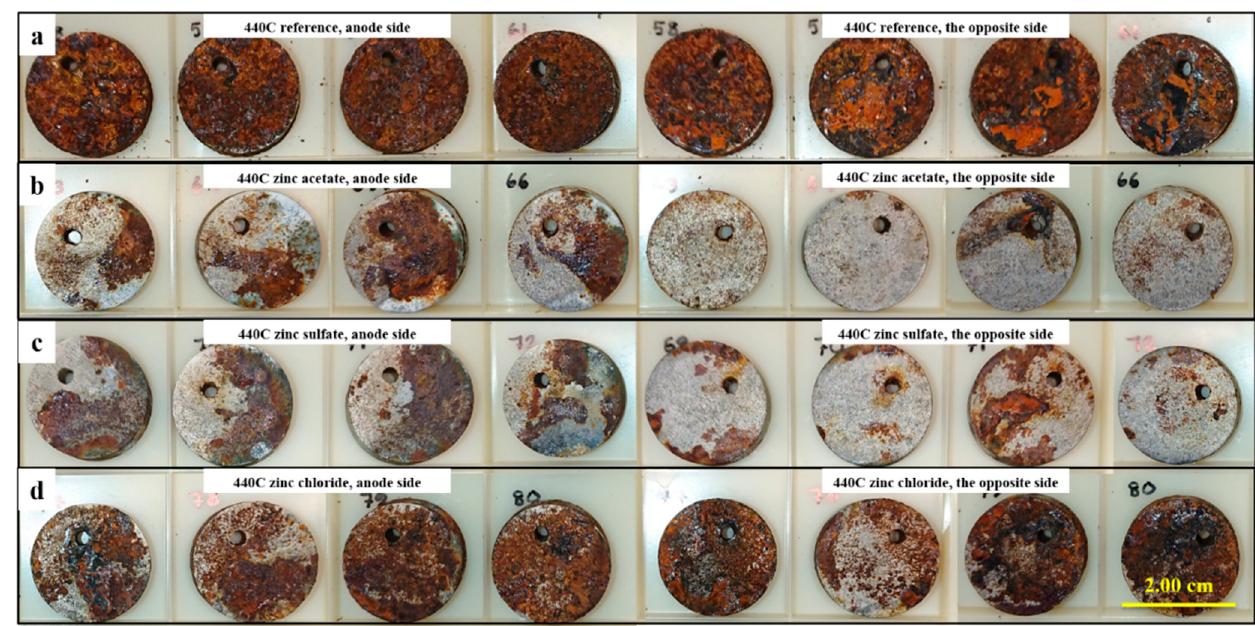
Figure 5. Images of porous 440C stainless steel samples with 30 wt% porosity after the 240 h corrosion test. References without zinc ( a ), zinc acetate electrolyte ( b ), zinc sulfate electrolyte ( c ), and zinc chloride electrolyte ( d ) are displayed from both sides (the anode side and the opposite side relative to the anode) of the sample.